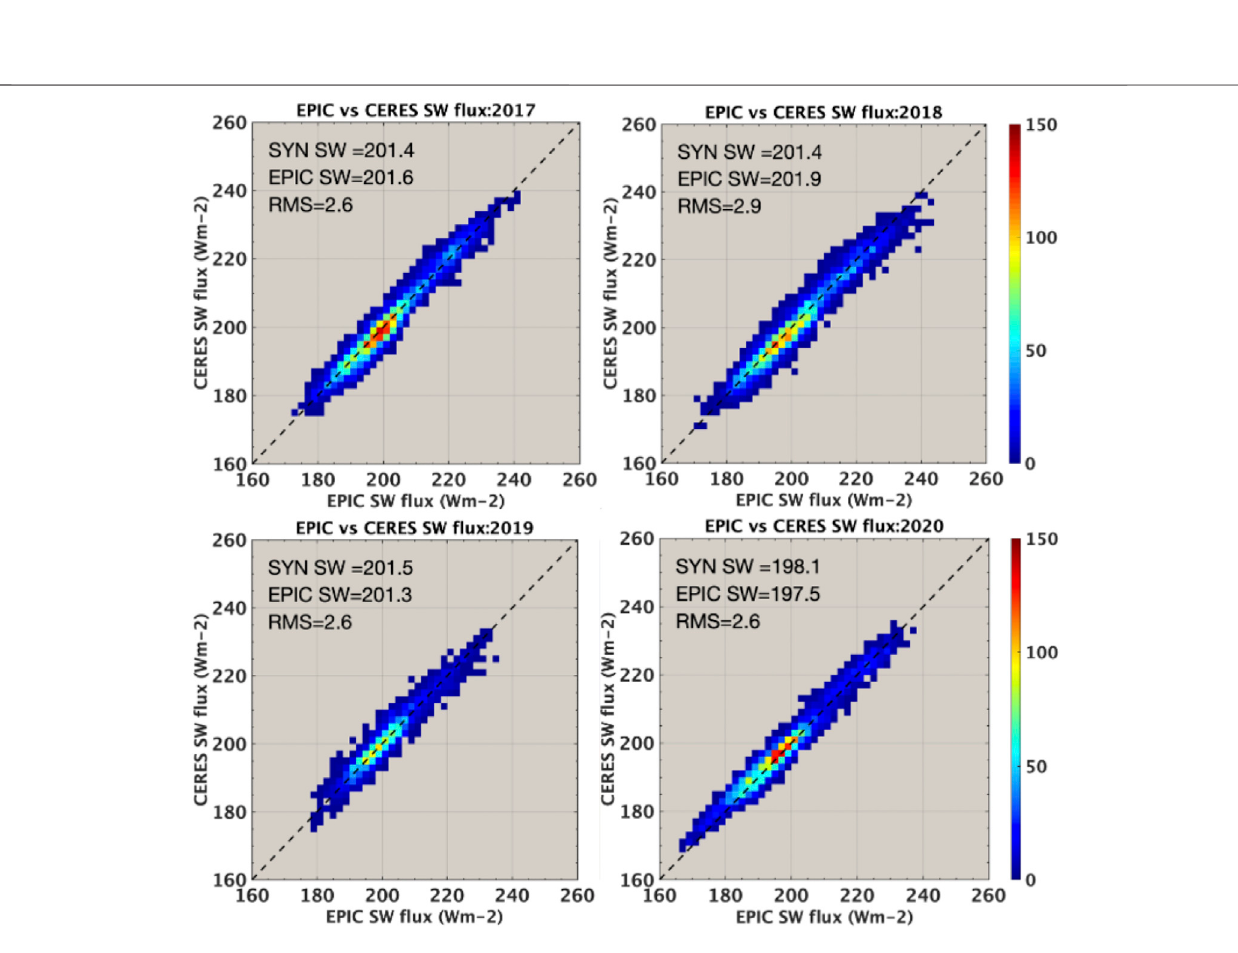
Frontiers in Remote Sensing |